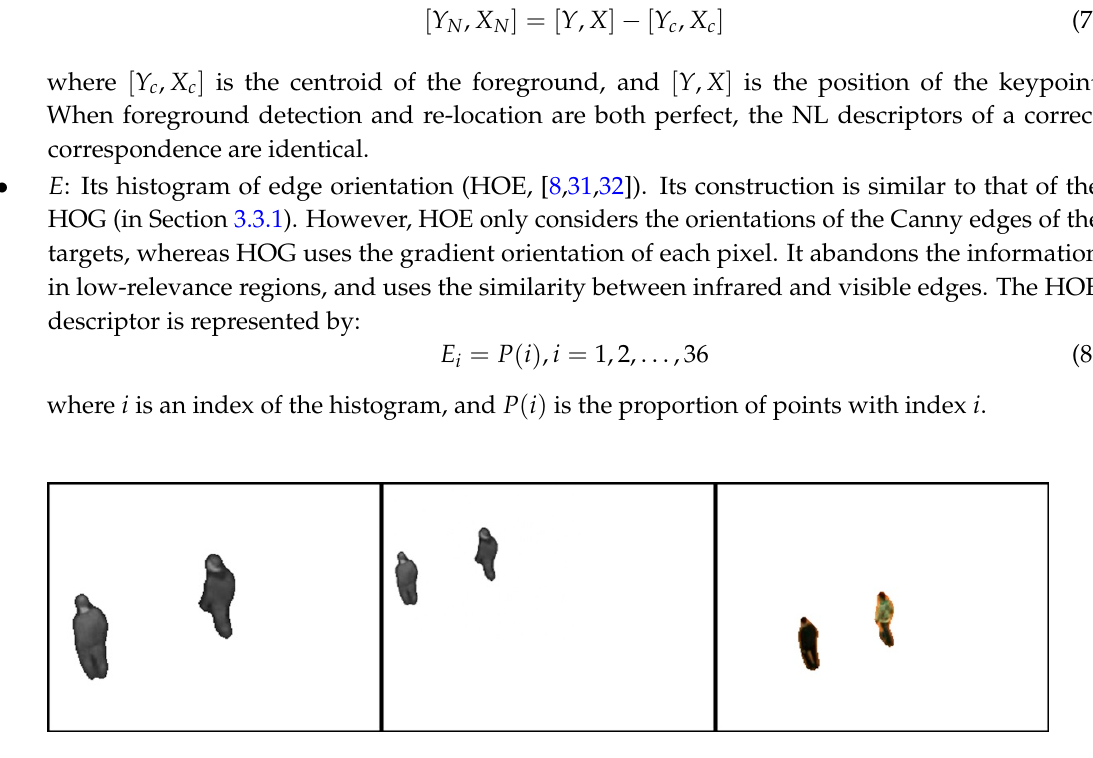
Figure 5. Infrared targets obtained before carrying out transformation ( left ) and after the transformation ( middle ); and the visible target without transformation ( right ).